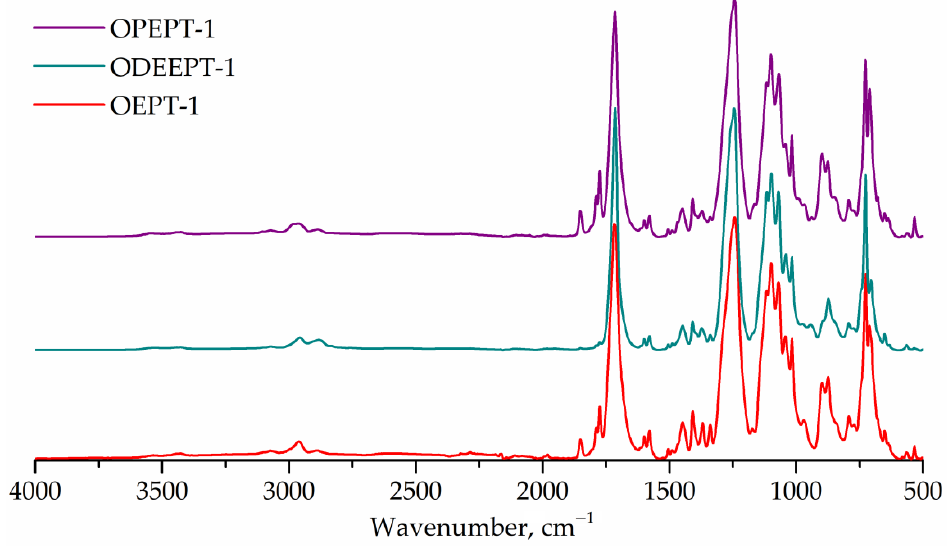
Figure 7. FTIR spectra of OEPT-1, ODEEPT-1, and OPEPT-1 samples. Figure 8 represents the GPC curves. The GPC curves of all three samples are flat and trimers being distinguishable. The peak molecular weight was 3769 g/mol for OEPT- 1 sample, 3184 g/mol for ODEEPT-1, and 4031 g/mol for OPEPT-1.